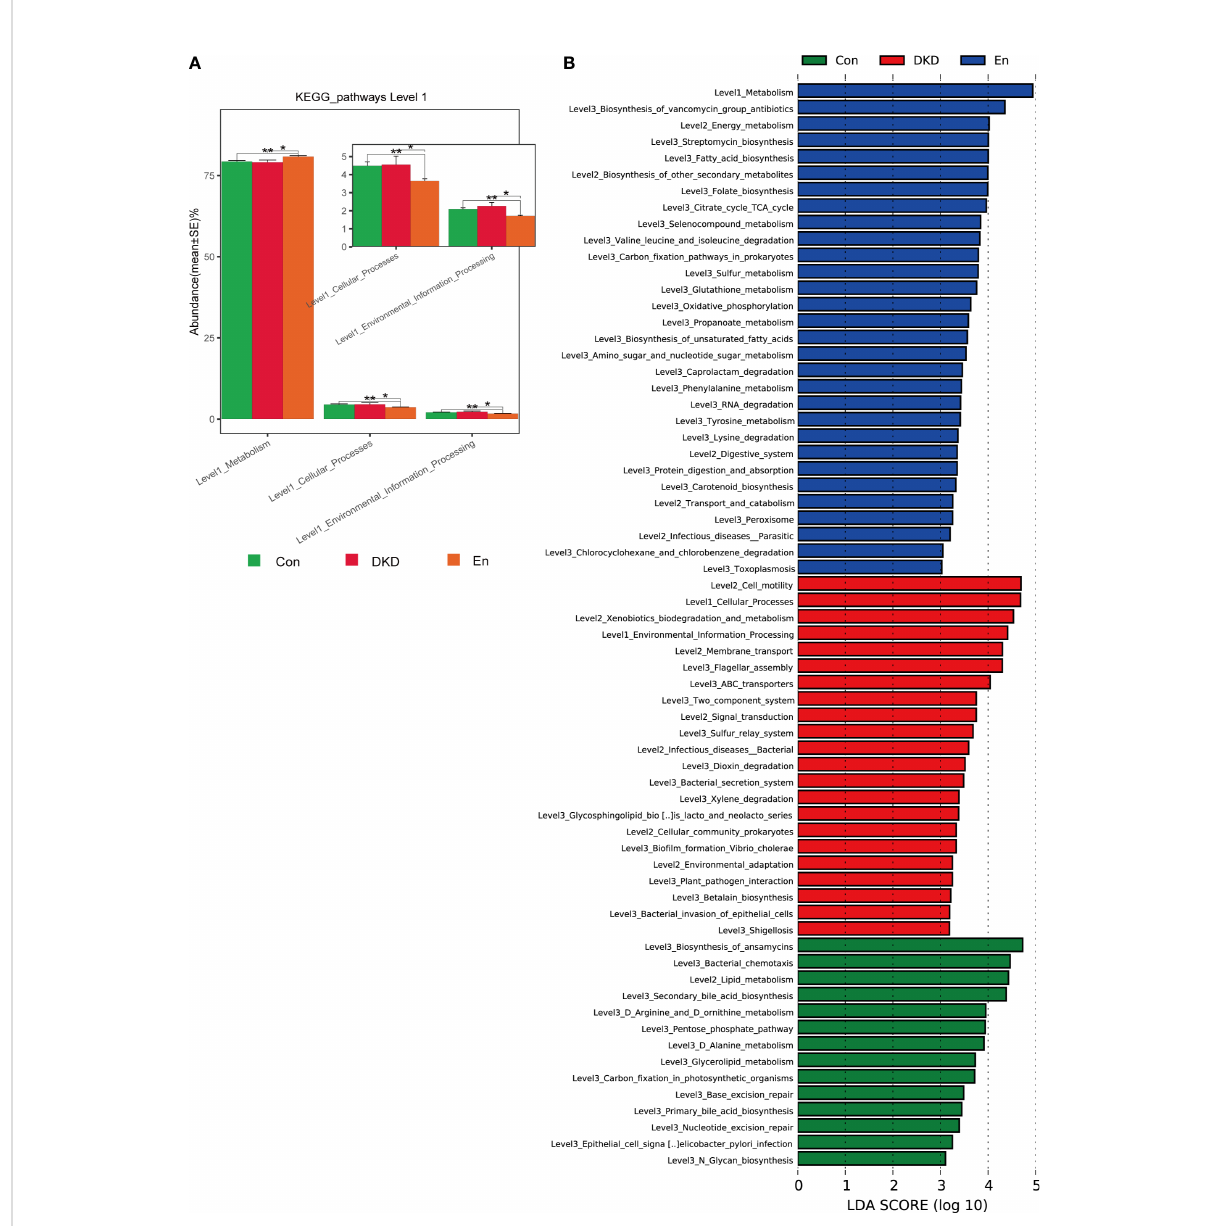
FIGURE 4 Predictive analysis of gut microbiota function based on KEGG database. (A) Complex bar plot of KEGG pathway abundance comparisons at level 1 among groups * p < 0.05, ** p < 0.01. (B) LefSe analysis of KEGG pathways (LDA ≥